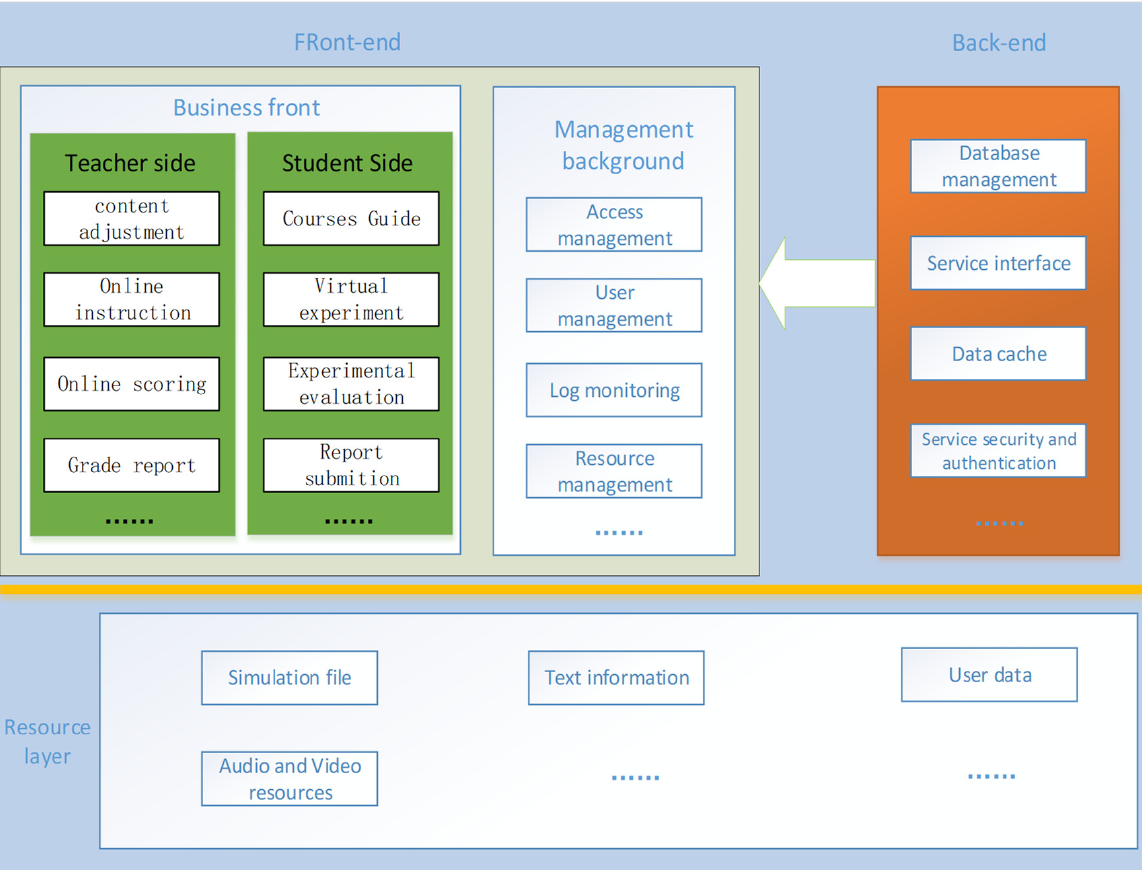
Figure 16. Overall framework diagram of the website deployment.